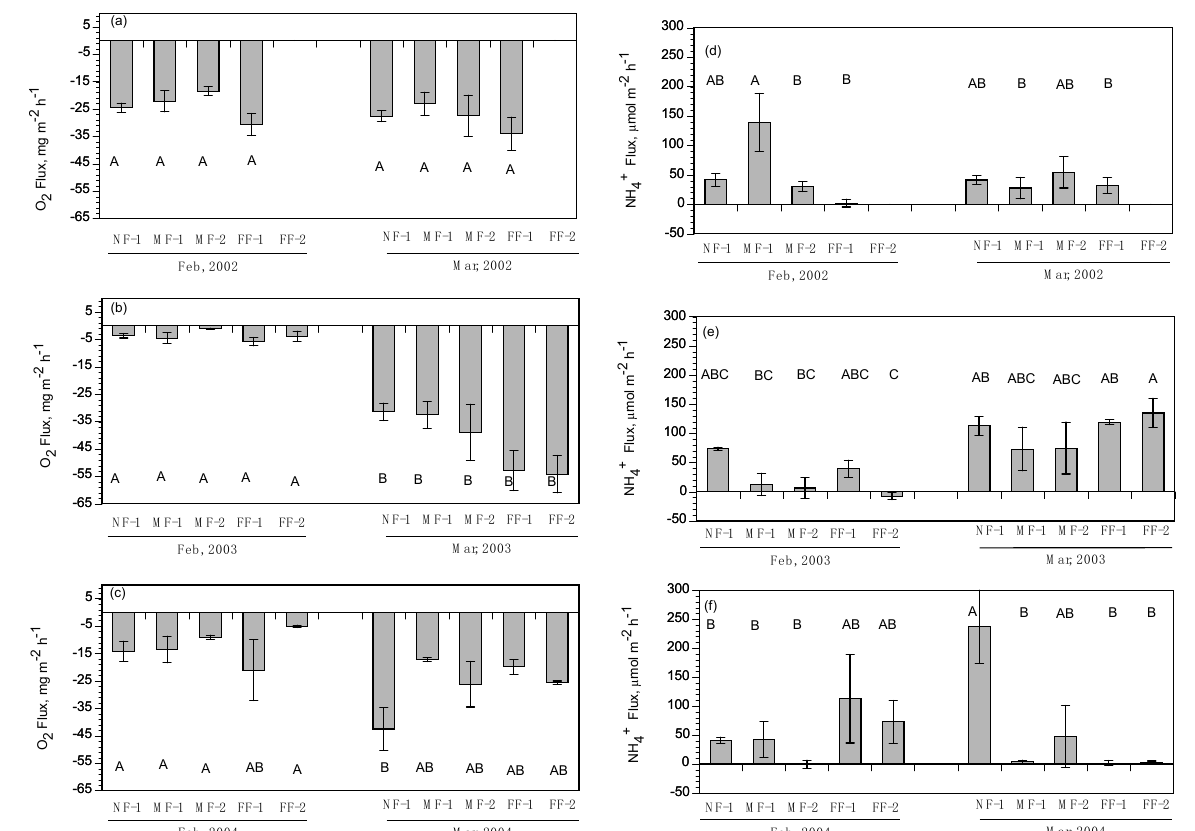
Figure 4. Subtidal benthic fluxes of dissolved oxygen (O 2 , a – c ) and ammonium (NH 4+ , d – f ) at five stations in Breton Sound during spring diversion pulses (February and March) in 2002 ( a , d ), 2003 ( b , e ), and 2004 ( c , f ). (NF = Near-field, MF = Mid-field, FF = Far-field).